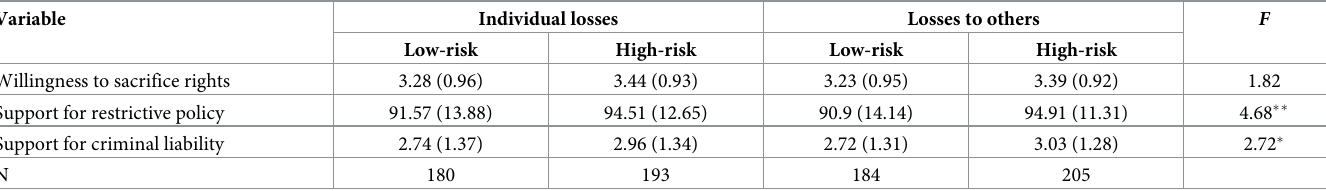
Table 3. Group means of experimental conditions in a completely randomized 2x2 factorial design.